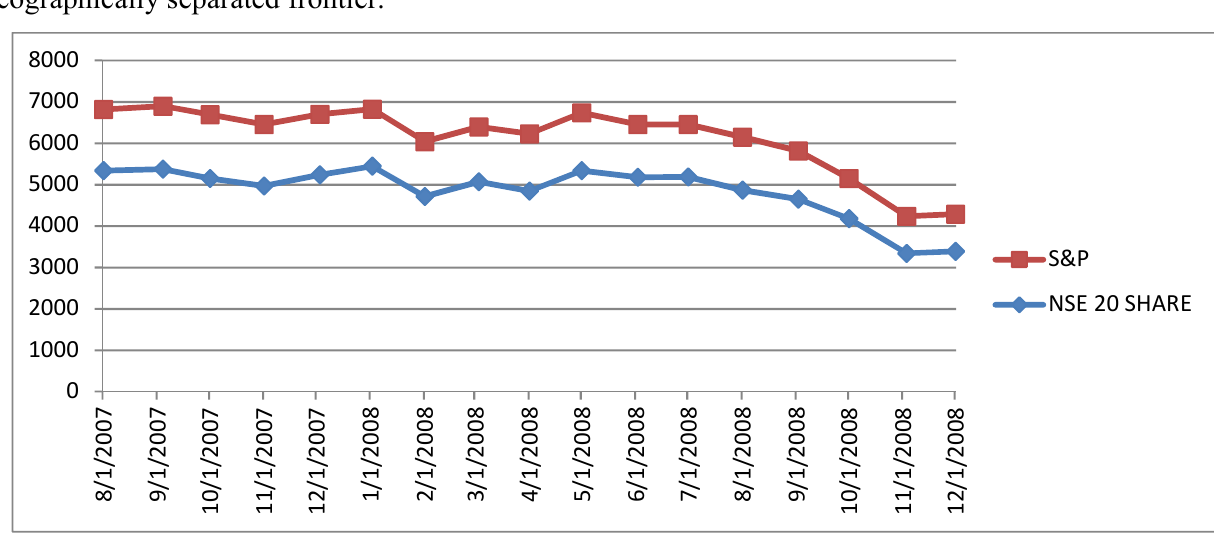
Fig. 4. Post Crisis Influence Of The NSE 20 Share Index on Standard & Poor’s Index